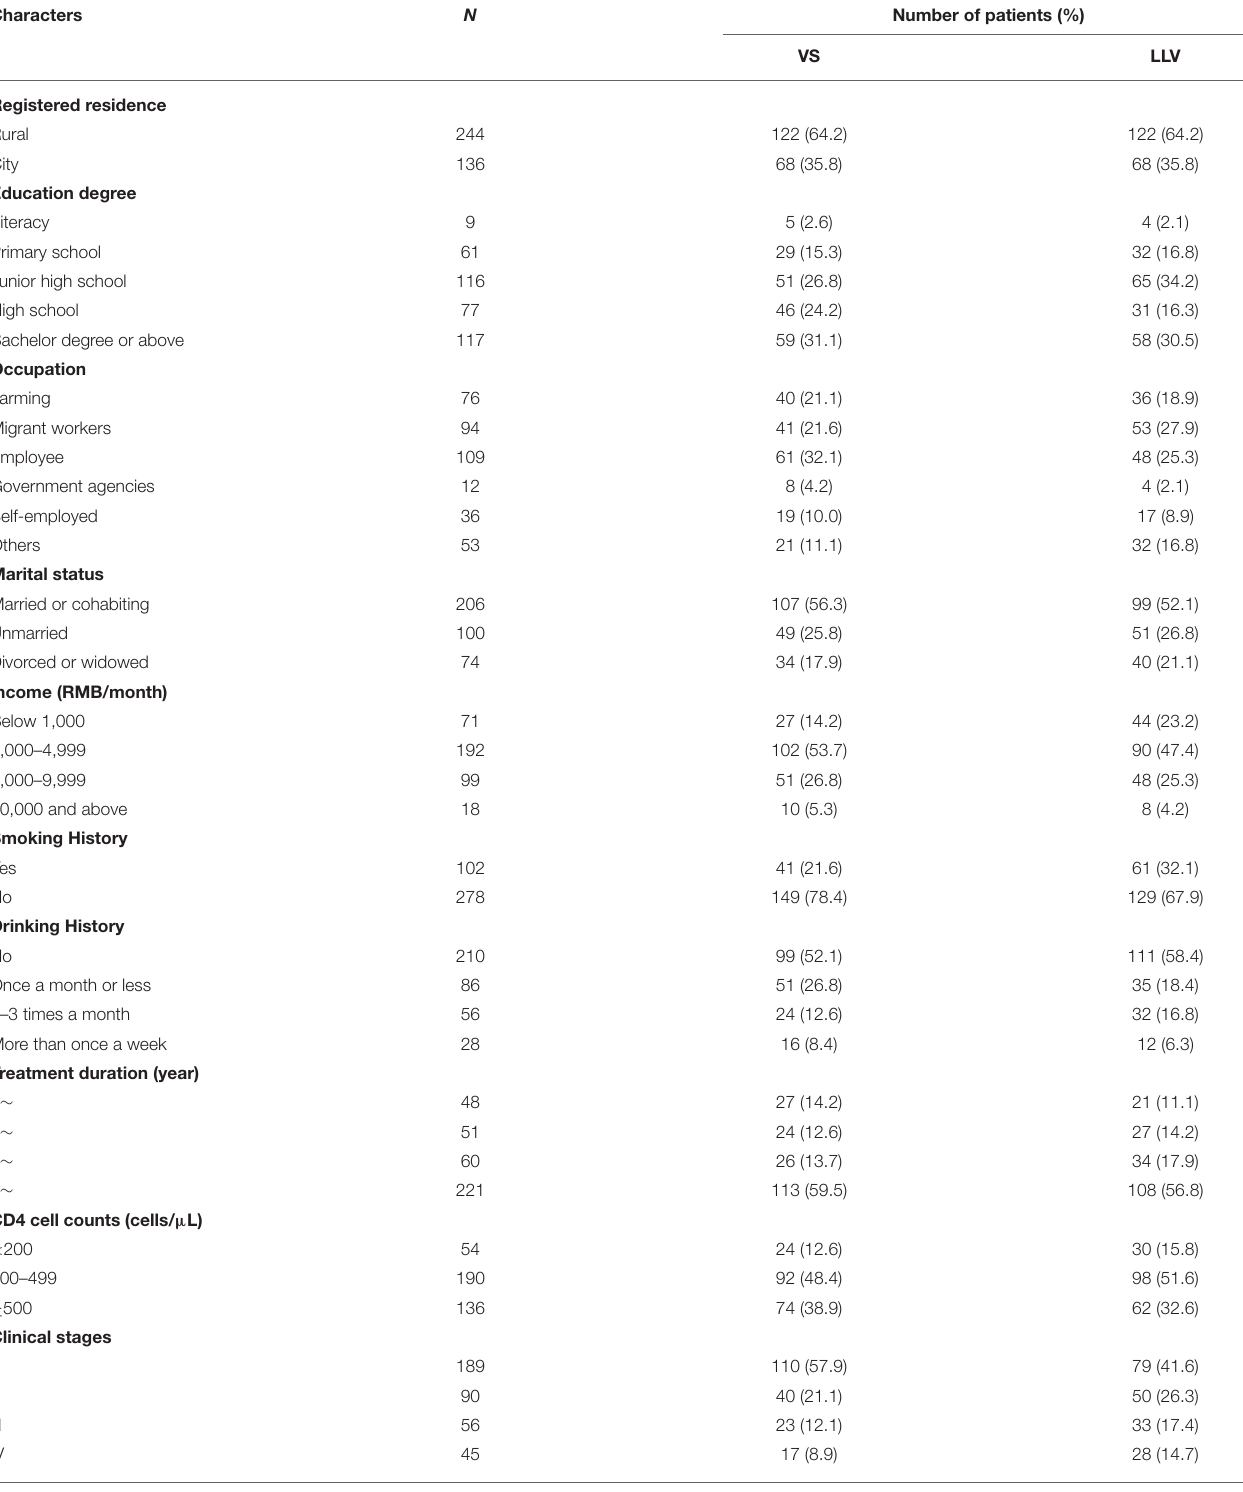
TABLE 5 | Characteristics of surveyed HIV/AIDS